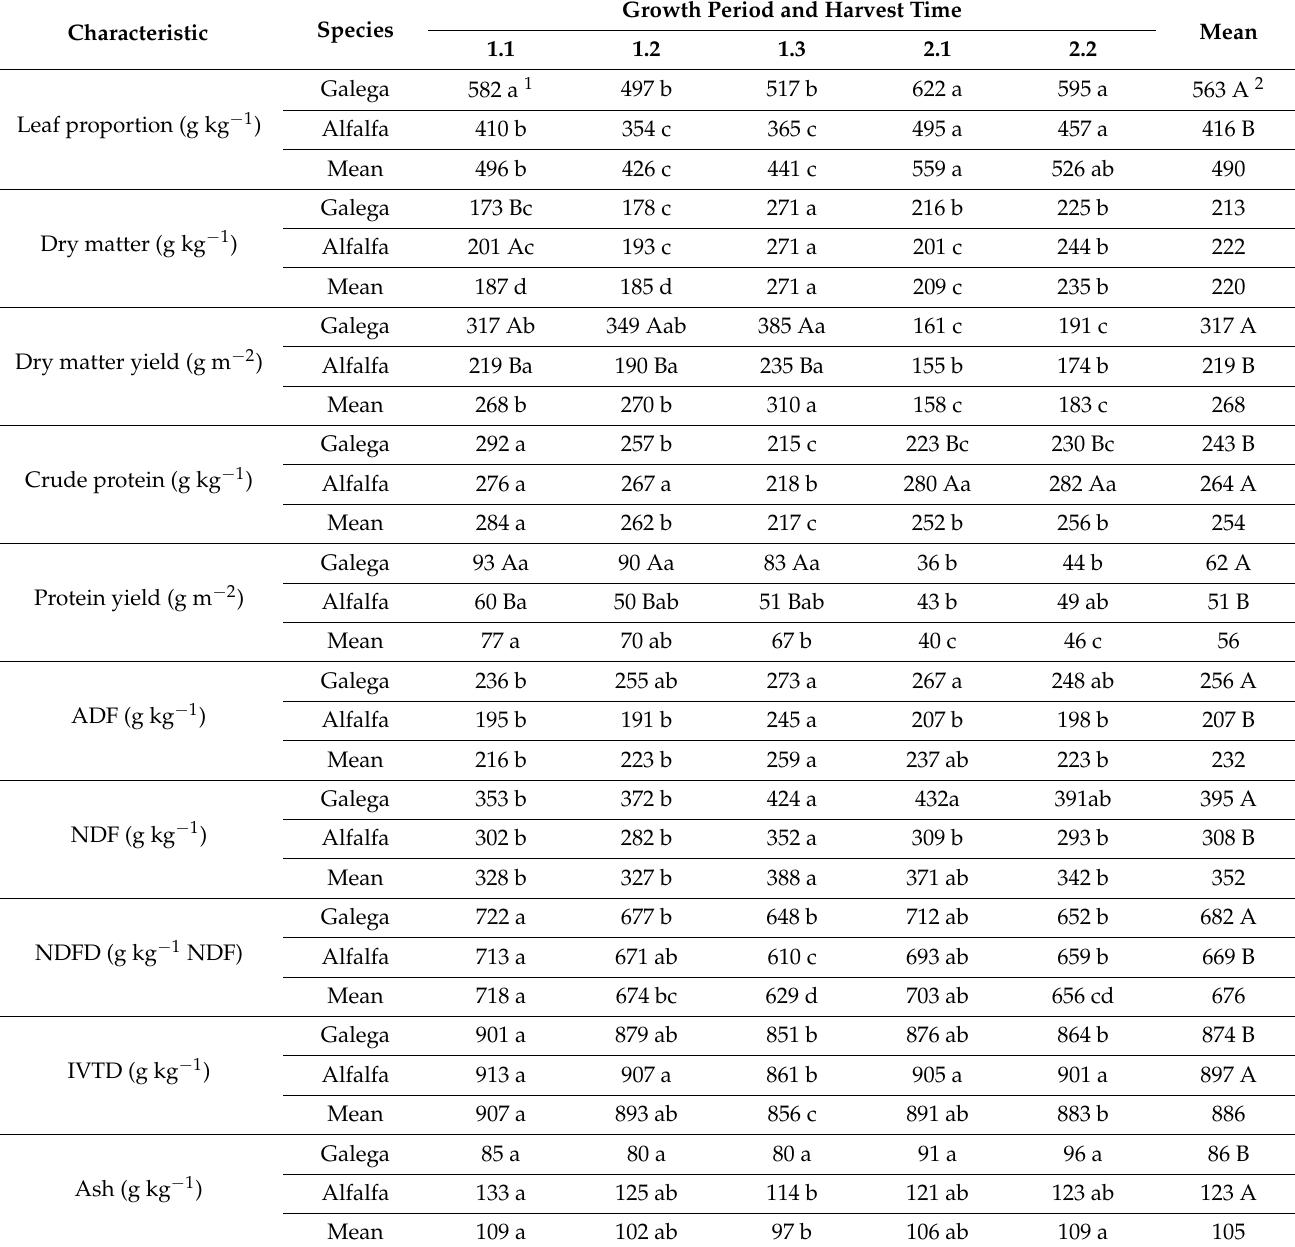
Table 3. Leaf proportion, dry matter concentration and yield, crude protein concentration and yield, ADF, NDF, NDFD, IVTD, and ash in the leaves of galega and alfalfa at two growth periods and different harvest times (means over two